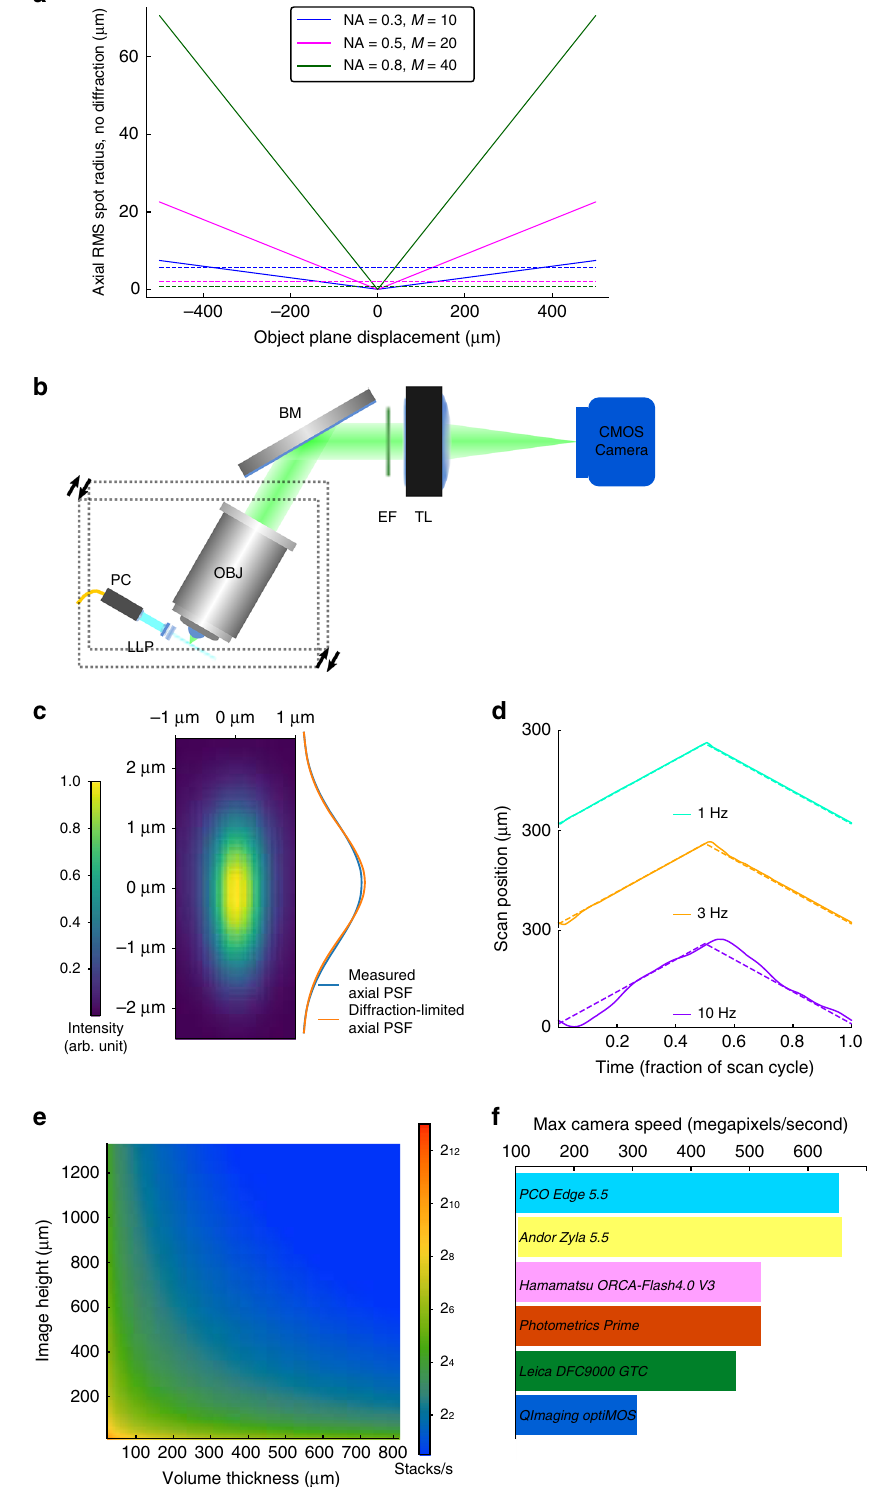
follow high frequency commands (Fig. 1d). This failure can have catastrophic consequences for 3D imaging at high rates. Unwanted oscillations in the scan system can result in both undersampling and oversampling in the axial dimension. Optical sections may also appear out-of-order since the axial position may not be strictly increasing/decreasing between